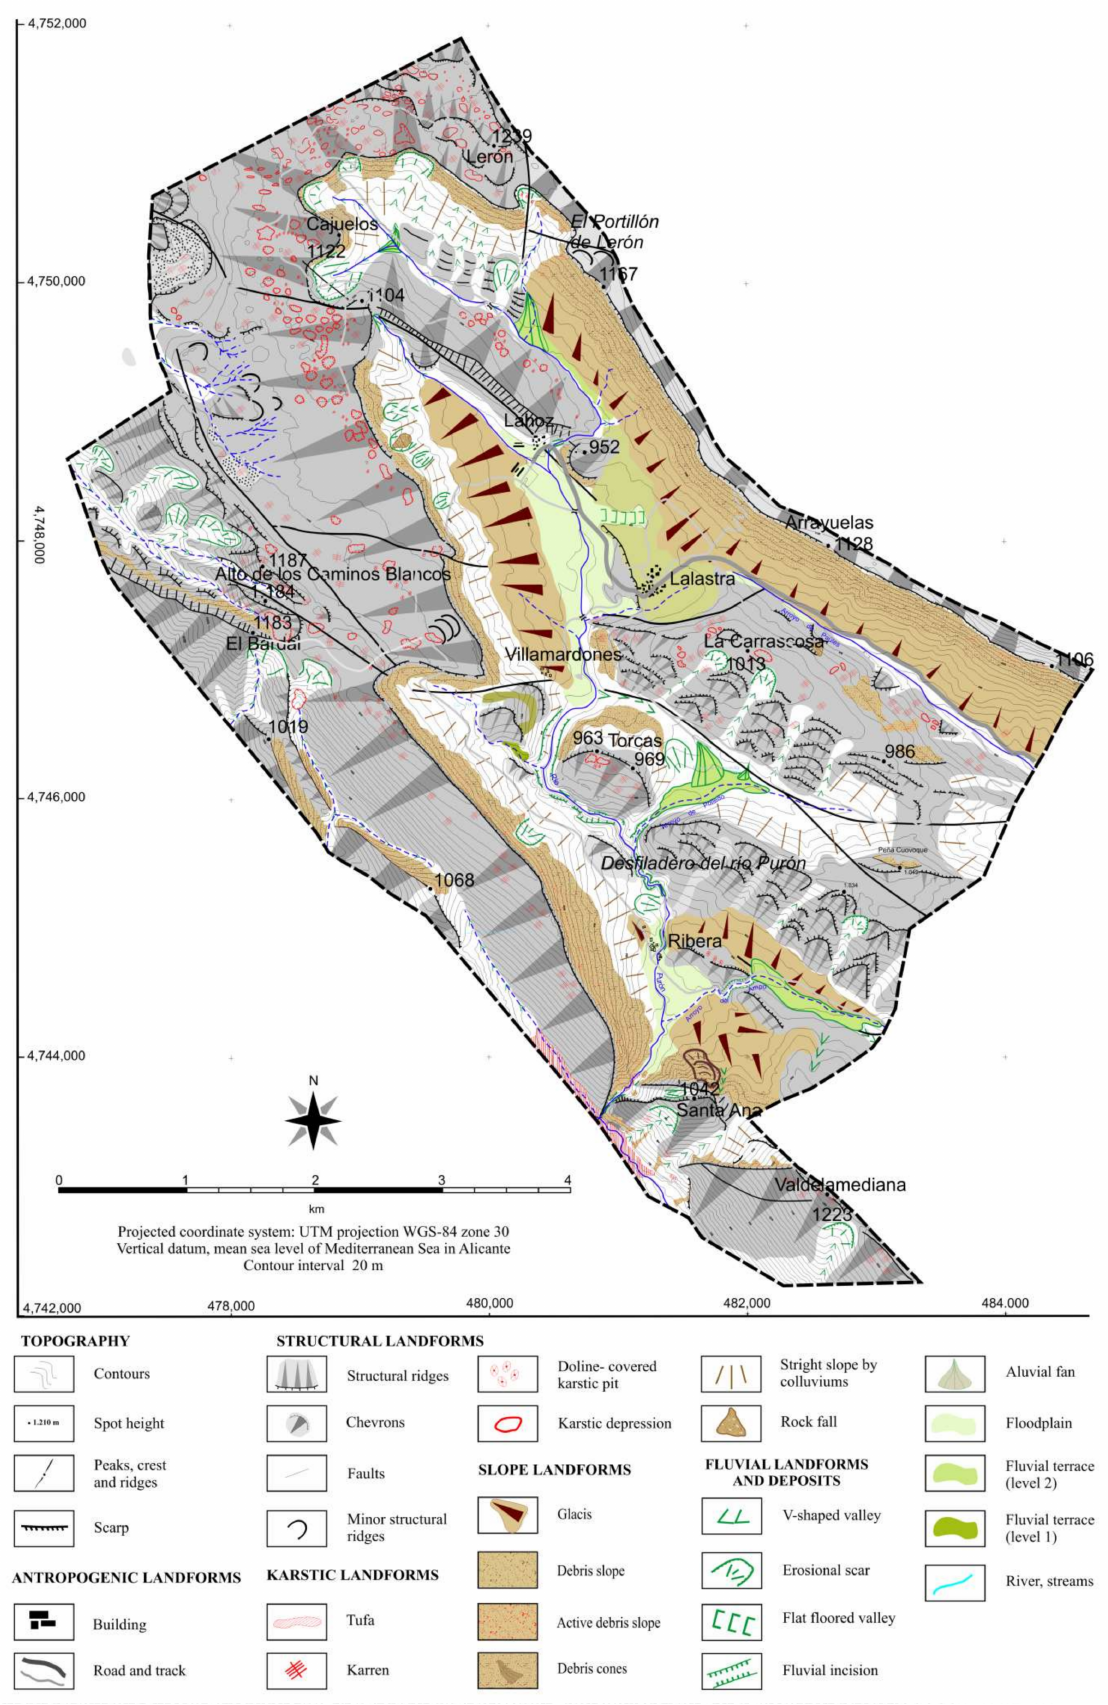
Figure 5. Geomorphological map of Valderejo Natural